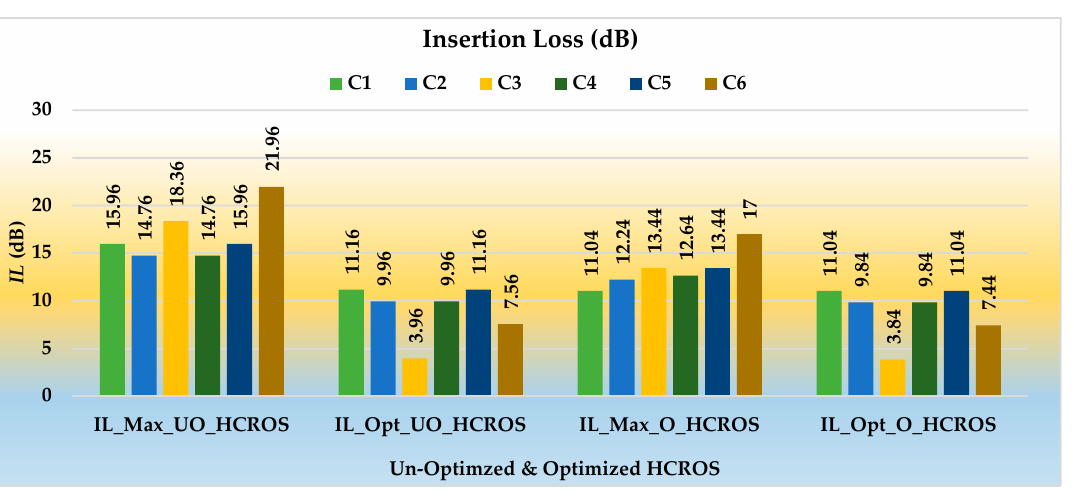
Figure 17. Maximum insertion loss IL (dB) of un-optimized and optimized HCROS for 6 I/O links.